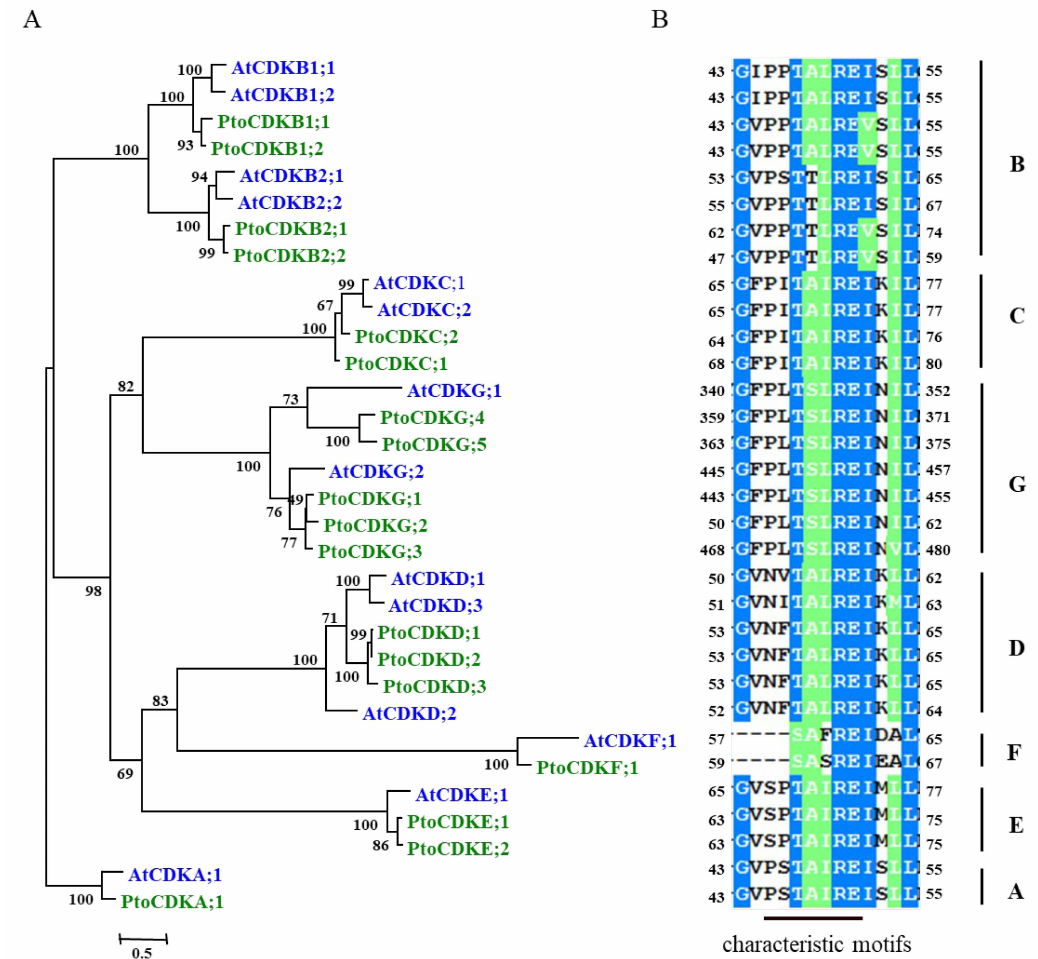
Figure 6. Identification and sequence analysis of members of the cyclin-dependent kinases (CDK) family in Populus . ( A ) Phylogenetic tree of Populus and Arabidopsis CDK members. ( B ) Characteristic motifs of different CDK